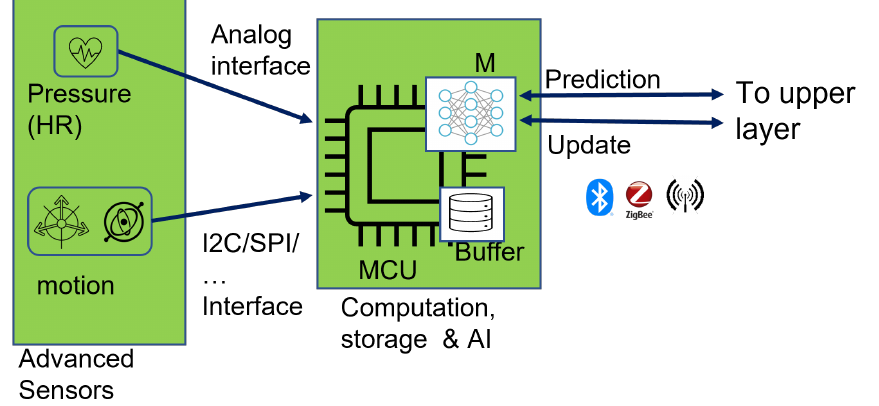
Figure 3. Intelligent Data Acquisition